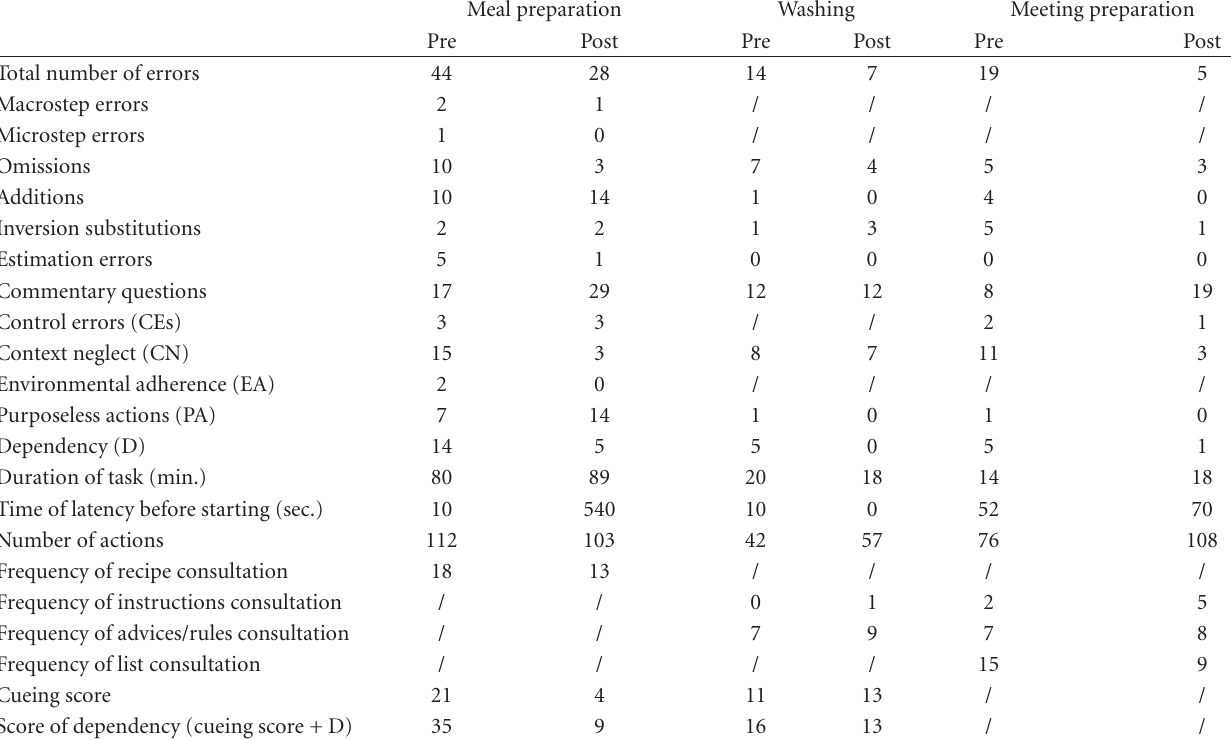
Table 4: G. O.’s results on the meal preparation, washing, and meeting preparation